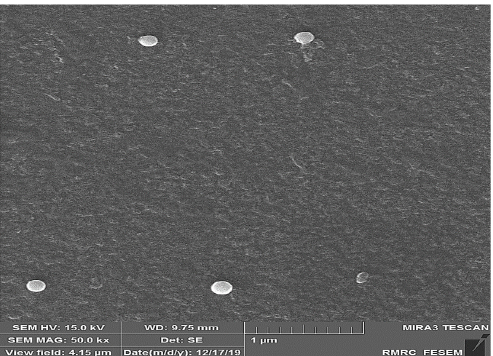
Figure 1. FE-SEM image of SeN. According to the picture, the size of nanoparticles is about 200 nm.